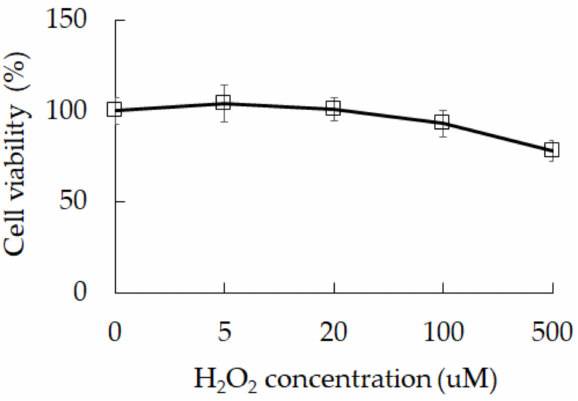
Figure 1. The cell viability of 3A-sub-E placental cells treated with H 2 O 2 for 24 h. Data were shown as mean ± SD (n =